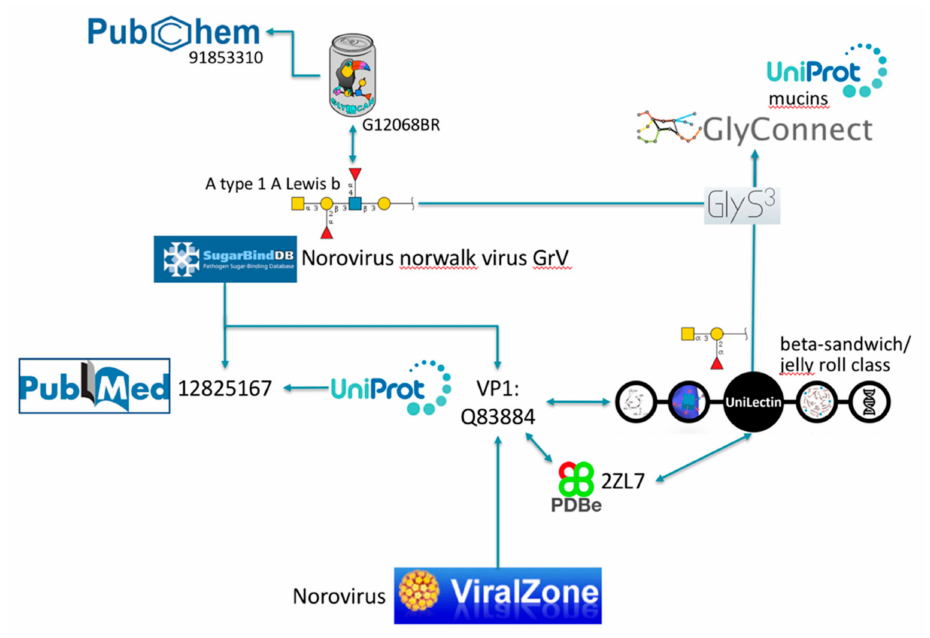
Figure 3. Example of exploration via